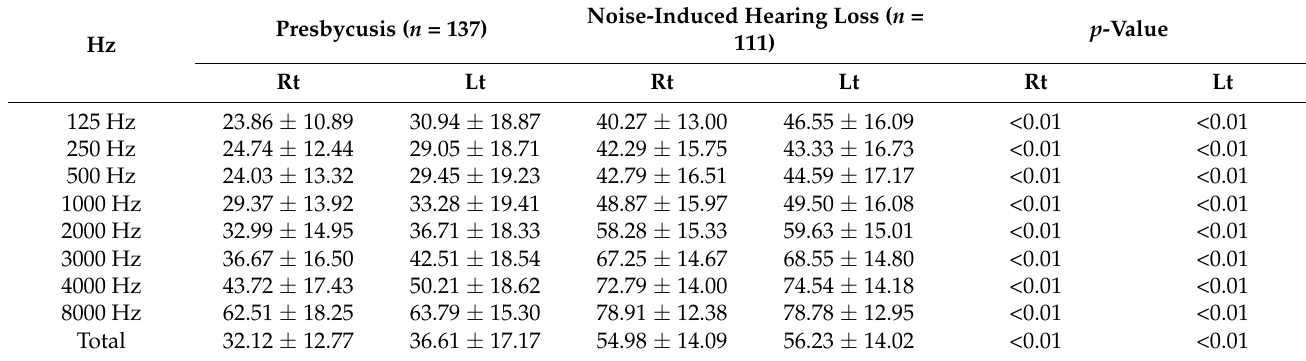
Table 2. Pure tone audiometry in patients with presbycusis and noise-induced hearing